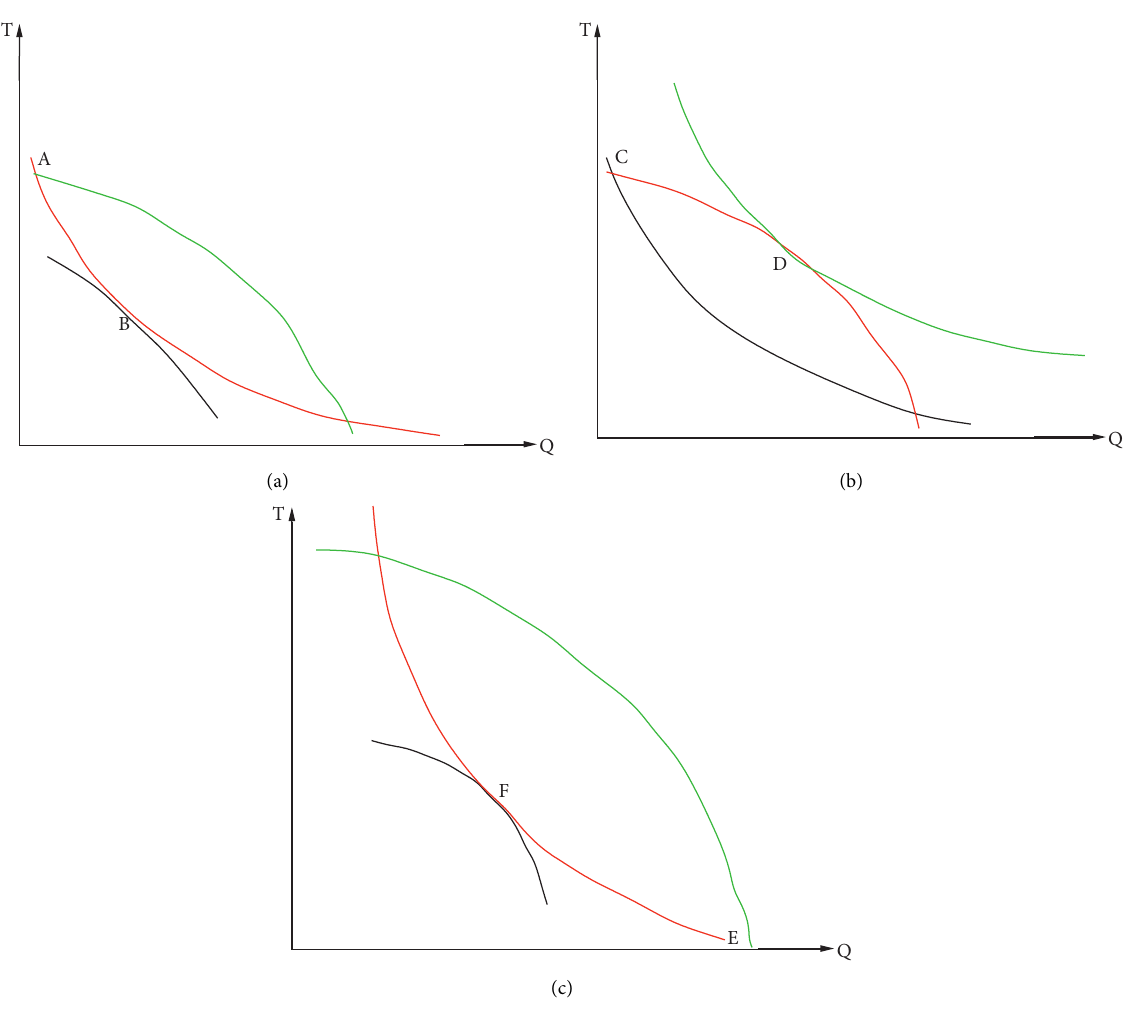
Figure 3: Profit indifference